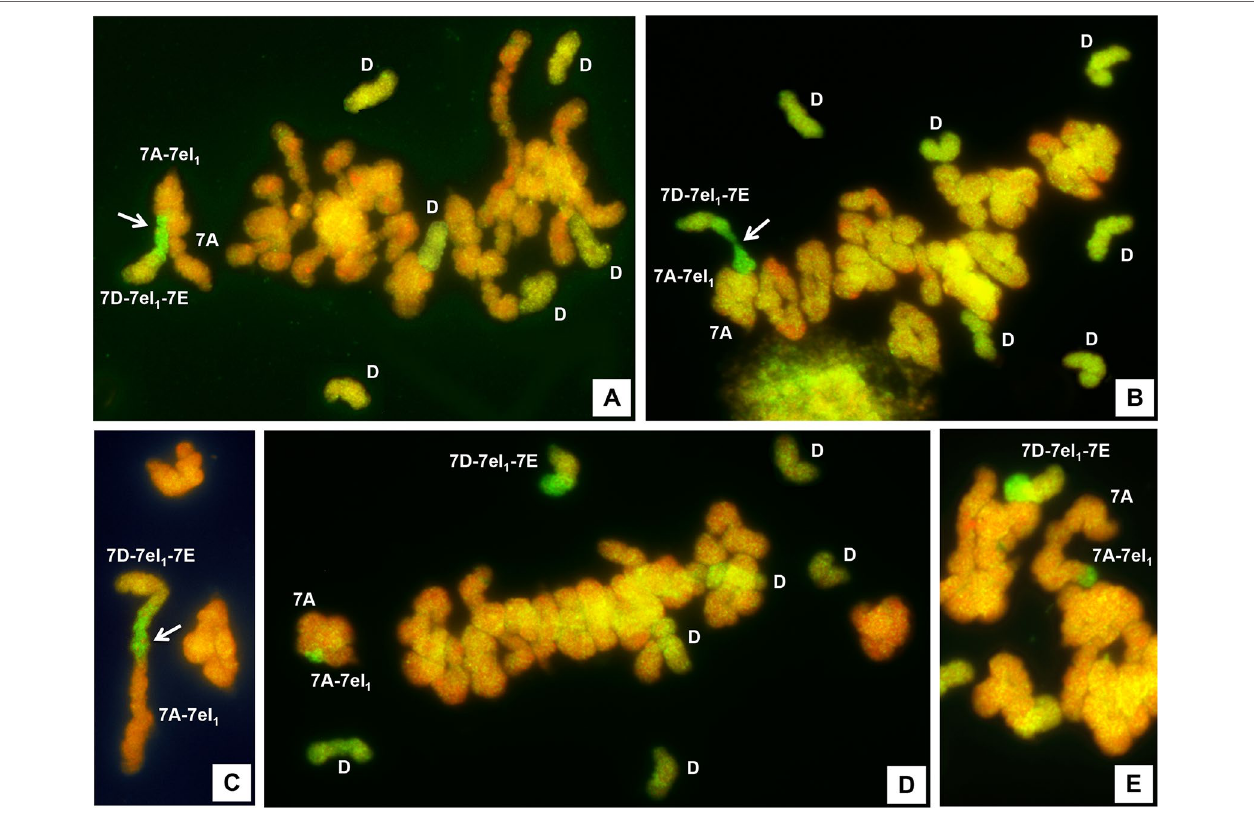
FIGURE 2 | GISH of pollen mother cells (PMCs) at meiotic metaphase I stage of 5x F 1 plants from the cross between R69-9 or R74-10 6x 7D-7el 1 -7E recombinant lines and R112 or R5 4x 7A-7el 1 recombinant lines. Pairing in the 7el 1 L segments shared by the respective recombinant chromosomes (arrowed) is highlighted by the GISH site (bright green fluorescence) in the open (A) or closed (B) trivalent, and in the rod bivalent (C) . In (D) and (E) , the R69-9/R74-10 recombinant chromosome is unpaired (univalent), while a ring (D) or rod (E) bivalent is established between a complete 7A (from the 6x parent) and the 7A-7el 1 chromosome from R112/R5. The greenish, univalent chromosomes from the D genome of the 6x parent are indicated (D) in plates (A) , (B) and (D)